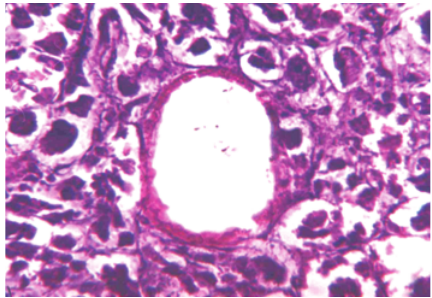
Figure 3: Sequence of thrombus formation: parietal thrombus pro- gressing centripetally (A); total thrombosis (B); vessel remodeling (C). Masson staining ( × 40).